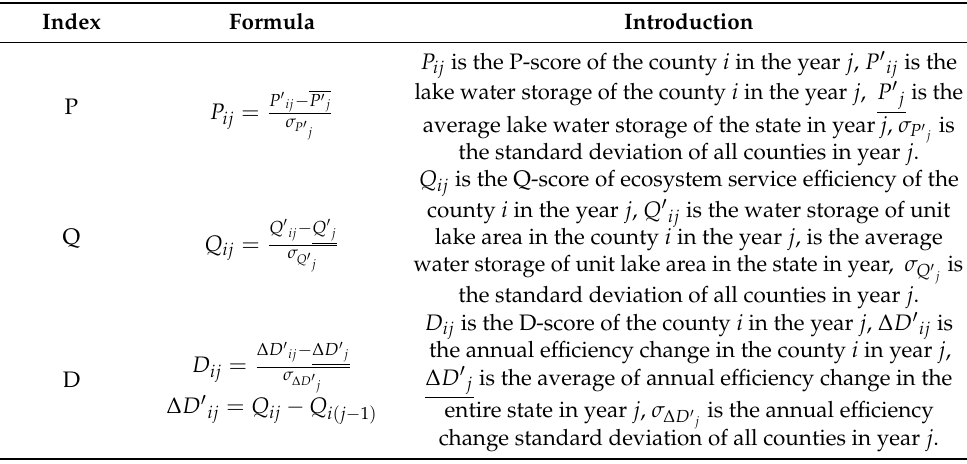
Table 2. Formulas of assessment indices.